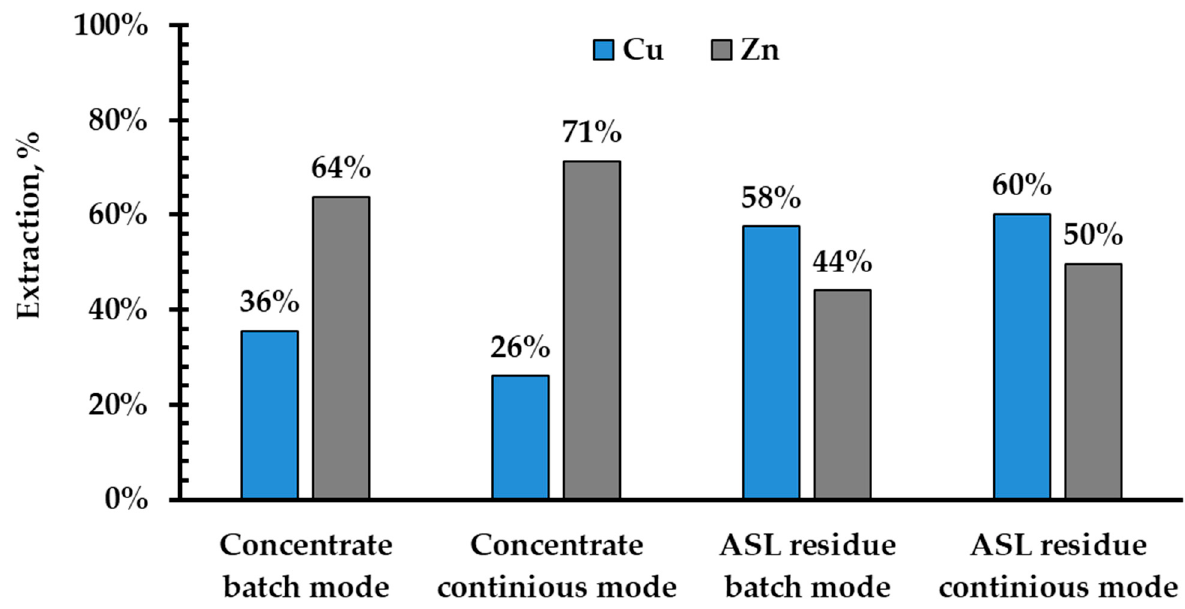
Figure 4. Cu and Zn extraction from concentrate and ASL residue in bioleaching experiments.